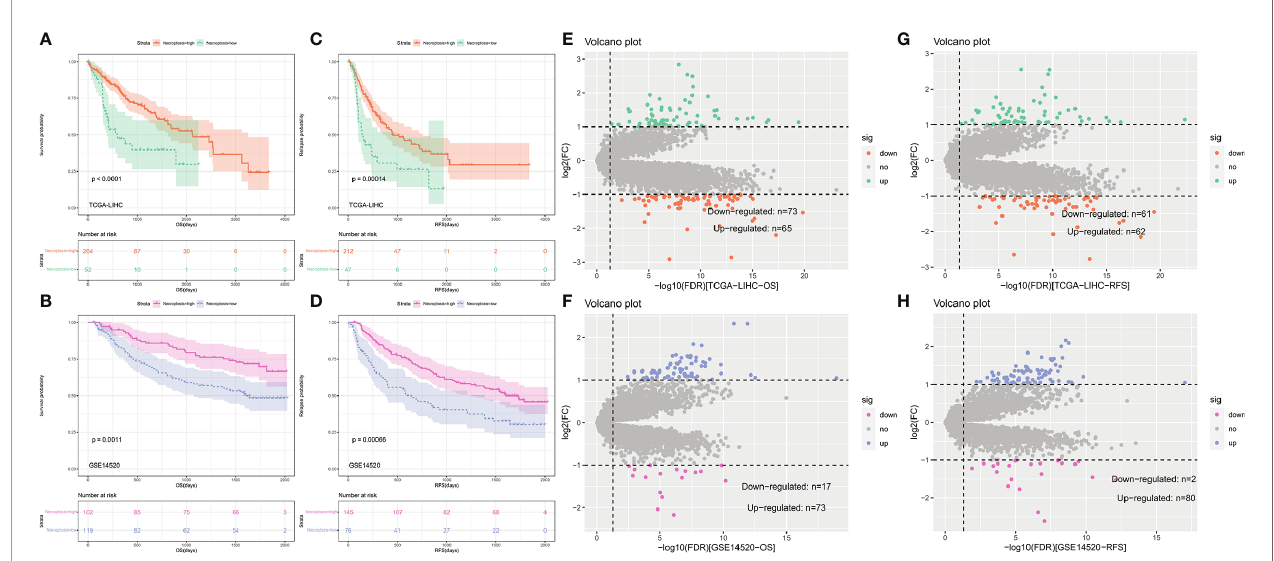
FIGURE 1 | Kaplan – Meier curves comparing the high and low necroptosis score and differentially expressed genes (DEGs) analysis. (A – D) Kaplan – Meier curves of OS and RFS in TCGA-LIHC and GSE14520. (E – H) Volvano plot of DEGs analysis in TCGA-LIHC and